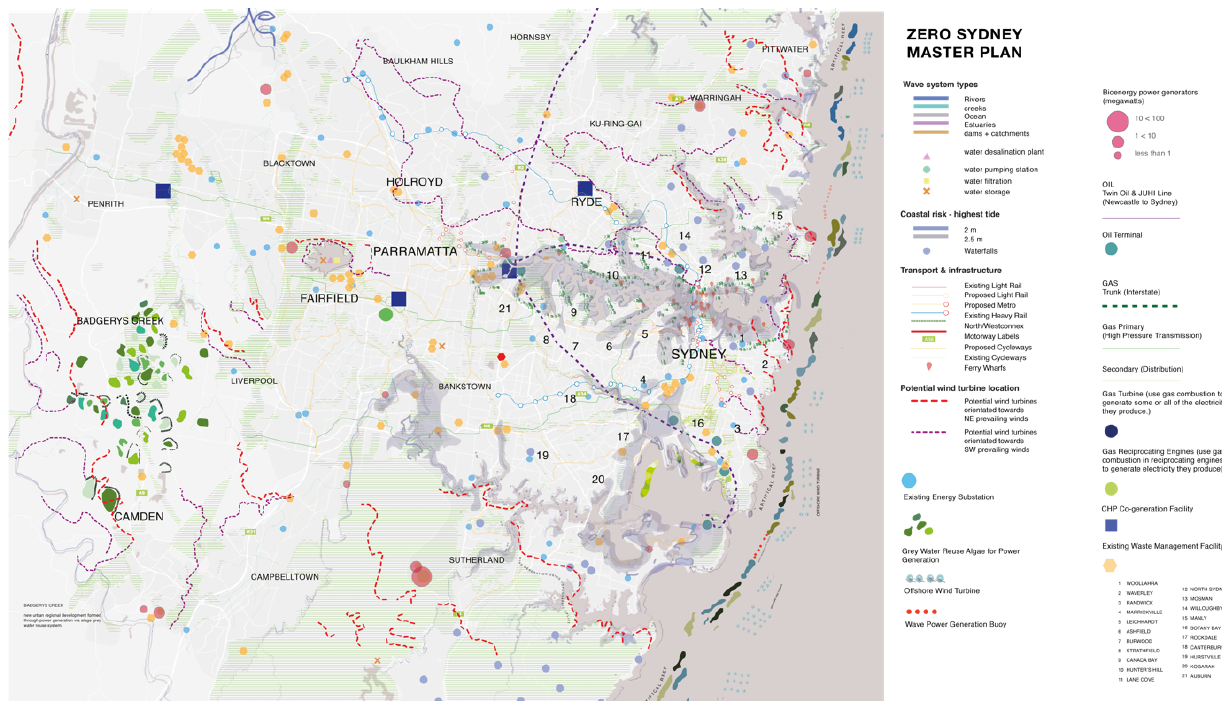
Figure 2. Sydney Barrier Reef (Roggema,